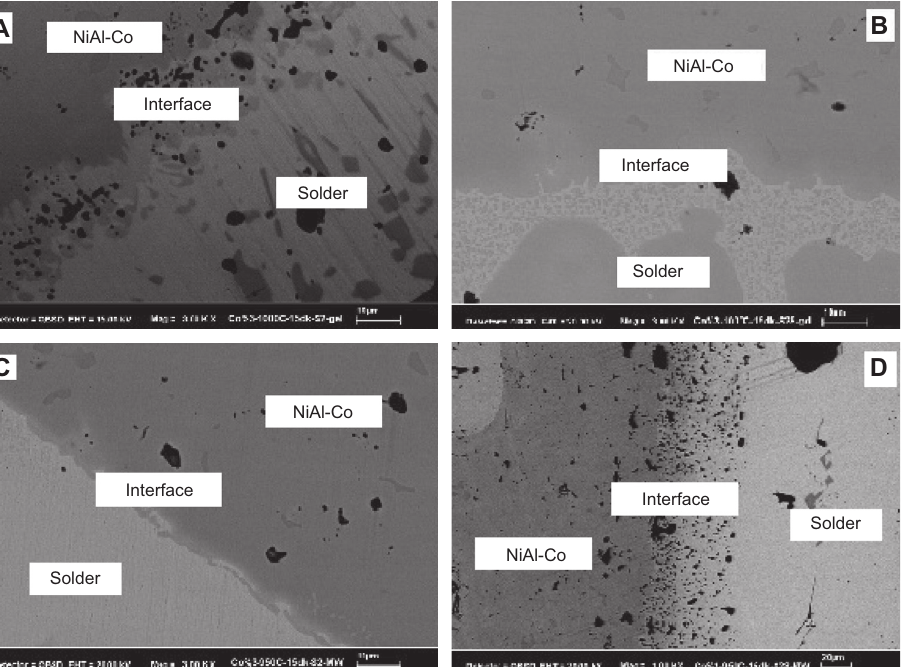
Figure 6 SEM images from Ni+Al+% 3 Co brazed for 15 min. (A) Braze-composite interface in a traditional furnace with a S2 brazing alloy; (B) braze-composite interface in a traditional furnace with a S28 brazing alloy; (C) braze-composite interface in a microwave furnace with a S2 brazing alloy; (D) braze-composite interface in a microwave furnace with a S28 brazing alloy.